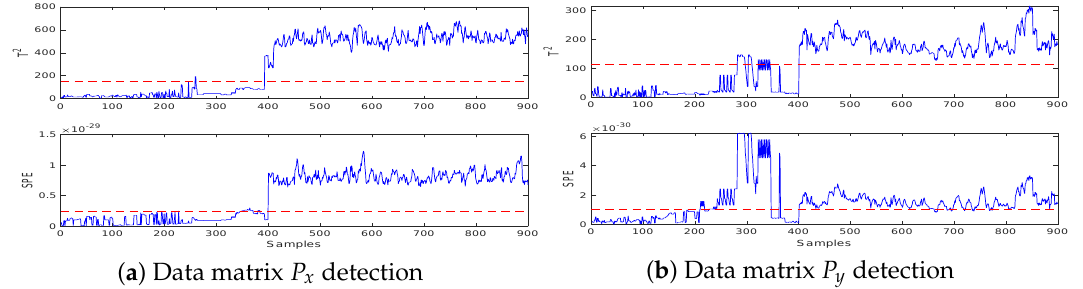
Figure 3. The input dataset. ( a ) Data matrix P x ; ( b ) Data matrix P y .